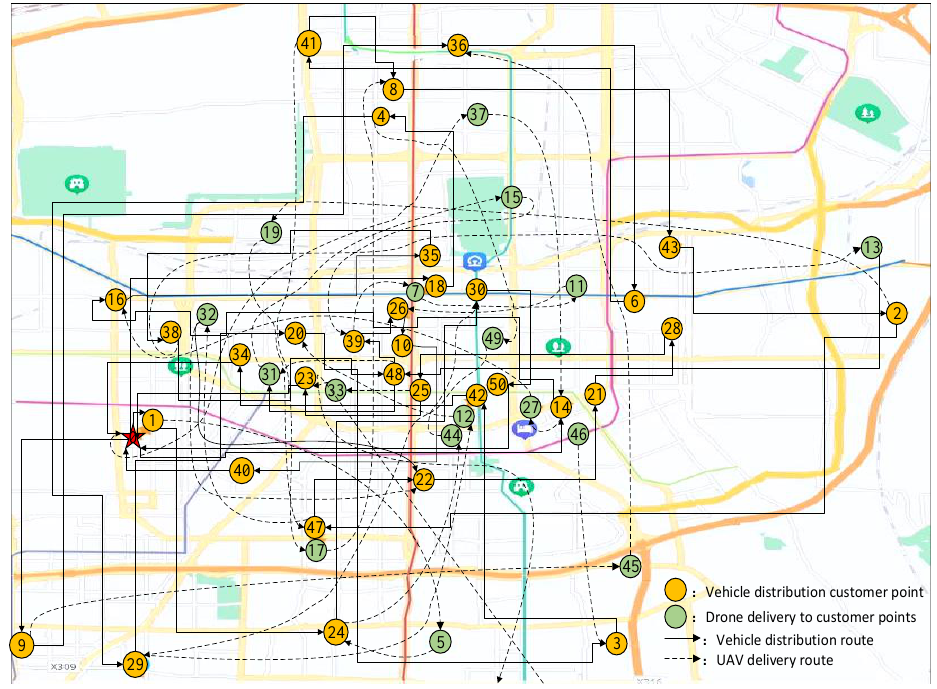
Figure 5. Optimal path for vehicle and UAV collaborative delivery.